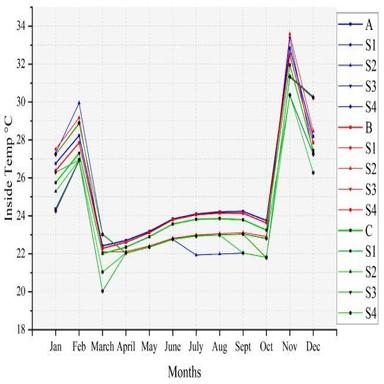
The monthly indoor temperatures and the monthly inside and external surface temperatures.